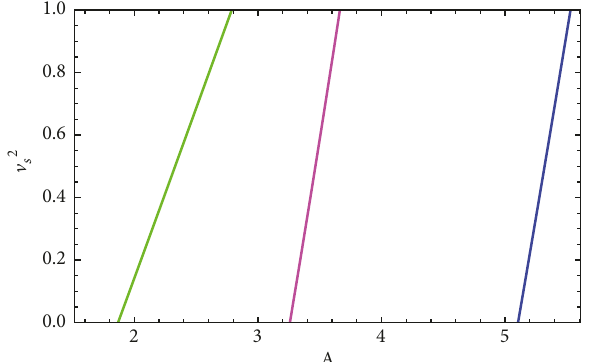
4 Figure 4: Plots of V 2 𝑠 versus 𝐴 for 𝛾 = −2,𝛼 = 0.1, 𝑑 = 1 with Figure 2: Plots of 𝜔 versus 𝑉 for 𝛾 = −2,𝐴 = 2,𝛼 = 0.1, 𝑑 = 1 with 𝑍 = −0.01 (green), 4 (magenta), and 7 𝑍 = −2 (green), −1.15 (red), 0 (blue), and 1 (brown).